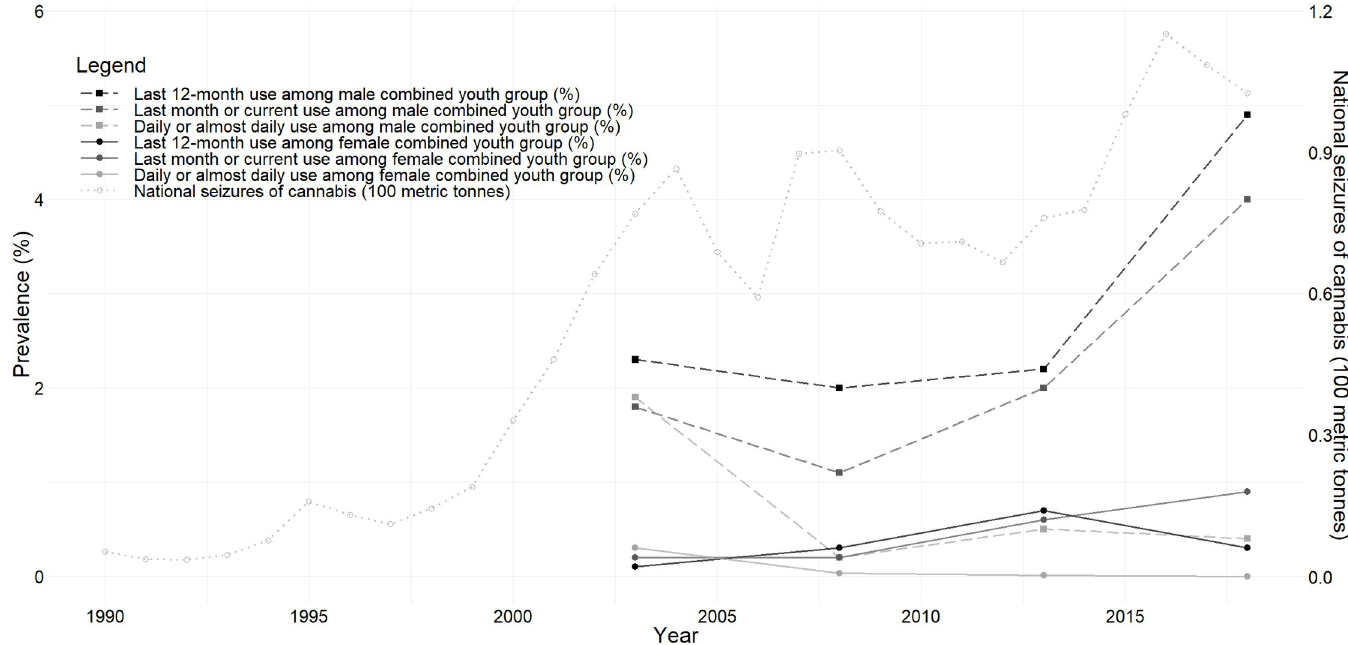
Fig 2. Time trend of cannabis use among “combined youth group” and national seizures of cannabis (100 metric tonnes- both resin and plant forms). The cannabis use among male and female of “combined youth groups” were pooled for 2000–2005, 2006–2010, 2011–2015, and 2016–2020 periods and were plotted in the middle of each